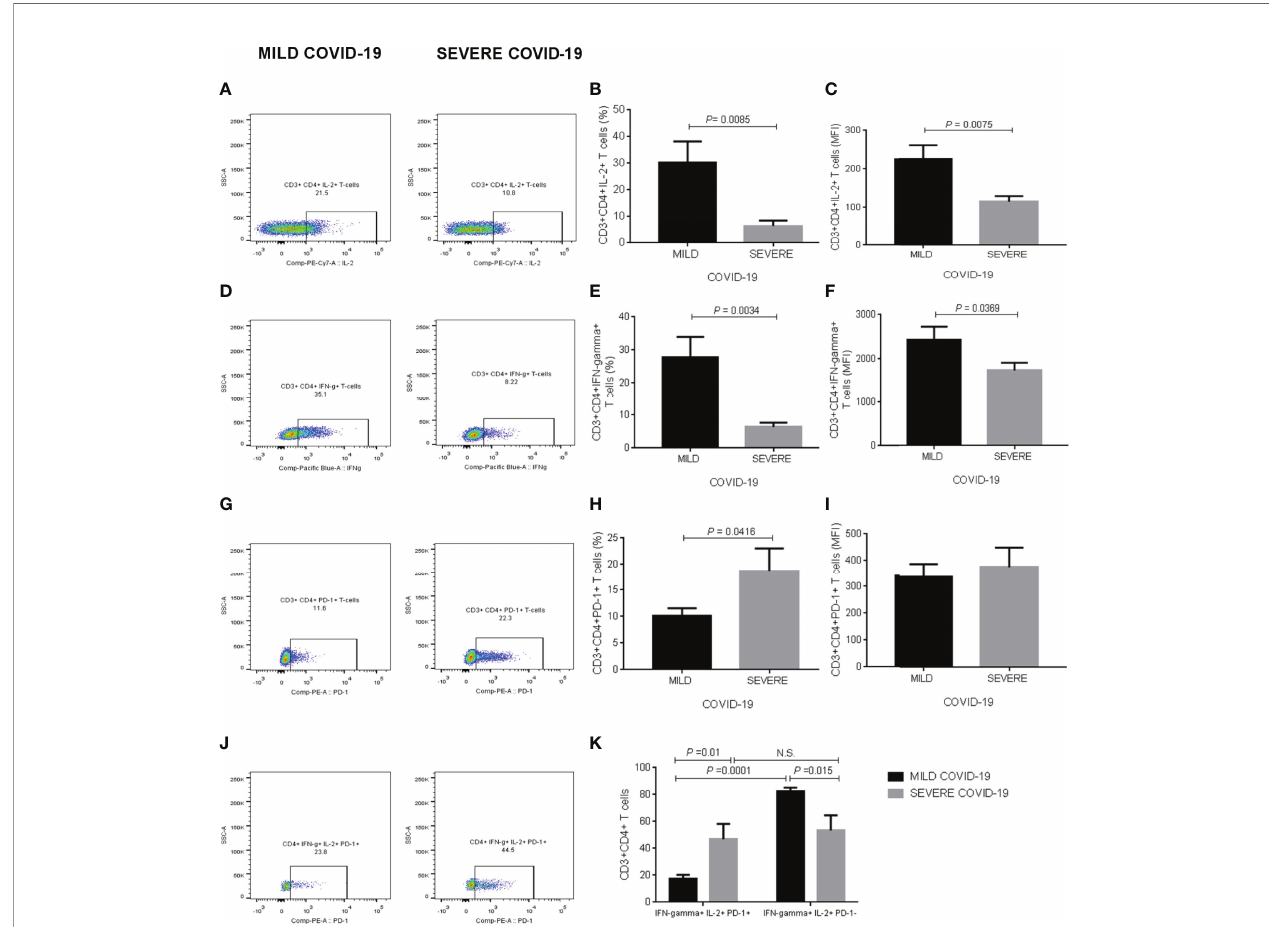
FIGURE 2 | IL-2, IFN-gamma, and PD-1 expression in CD3+CD4+ T cells in response to polyclonal stimuli in vitro . (A) Representative dot-plots illustrating the comparison of CD3+CD4+ T cells expressing IL-2 in blood samples treated with polyclonal stimuli from participants who developed mild or severe COVID-19 during the follow-up. (B) Percentage of CD3+CD4+ T cells expressing IL-2. (C) Mean fl uorescence intensity of IL-2 in CD3+CD4+ T cells. (D) Representative dot-plots exemplifying the contrast of CD3+CD4+ T cells expressing IFN-gamma in whole blood samples exposed to polyclonal molecules from participants who